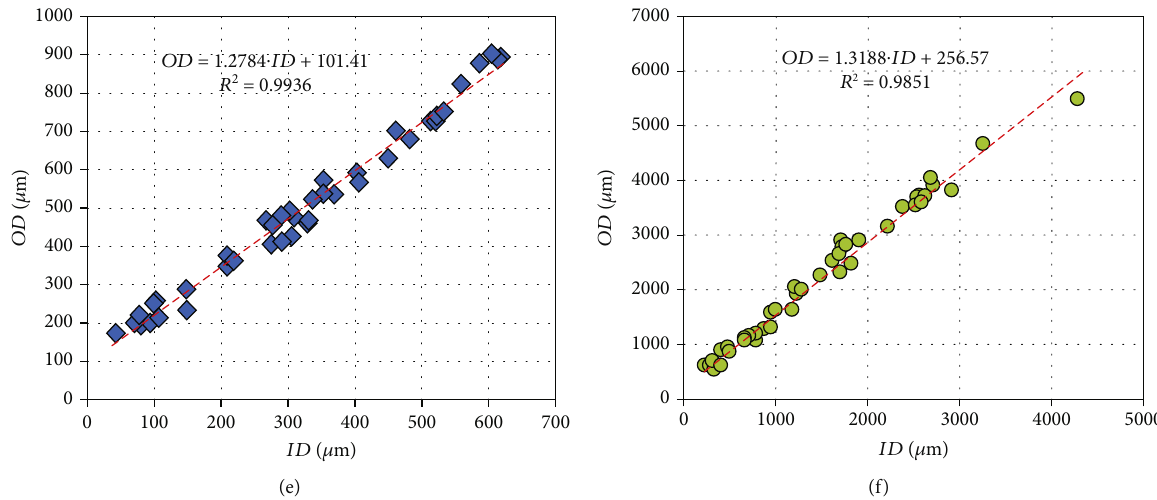
Figure 4: The linear regressions to calculate constant k for two cameras: (a) an example of the manual selection of discrete bubbles (e.g., in a smaller sample size for a demo) for determining k of Equation (4) by applying the linear regression, (b) the binarization of the selected bubbles, (c) the measurement of OD using ImageJ by following the standard procedure (targeted bubbles highlighted in black), (d) the measurement of ID by the new procedure (targeted bubble centroids highlighted in cyan), (e) high-resolution camera: Canon EOS Kiss × 4 SLR (18 megapixels), and (f) low-resolution camera: Canon Powershot A570 IS (7.1